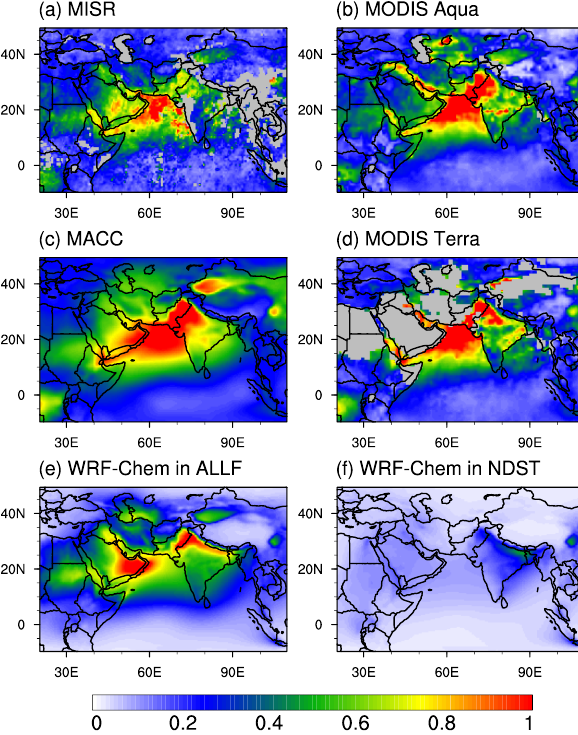
Figure 2. Left: precipitation (mmday − 1 ) from (a) TRMM, (b) GPCP, and (c) WRF-Chem (ALLF). Right: 850hPa GPH (shad- ing; unit: m) and wind (arrows; units:ms − 1 ) from (d) ERA-I, (e) MERRA, and (f) WRF-Chem (ALLF). All variables are aver- age for JJA 2008. In (e) and (f) , topography is marked out in gray.